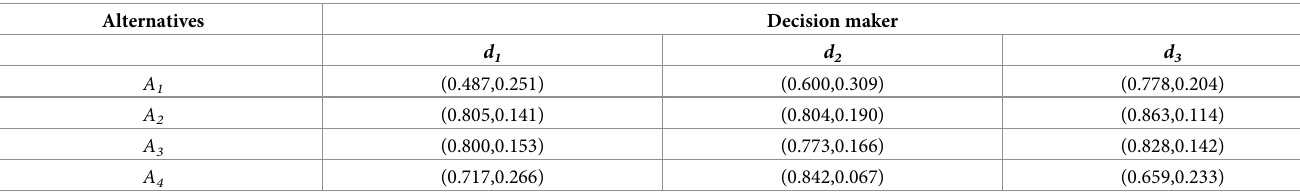
Table 3. Three weighted (on attributes) scores